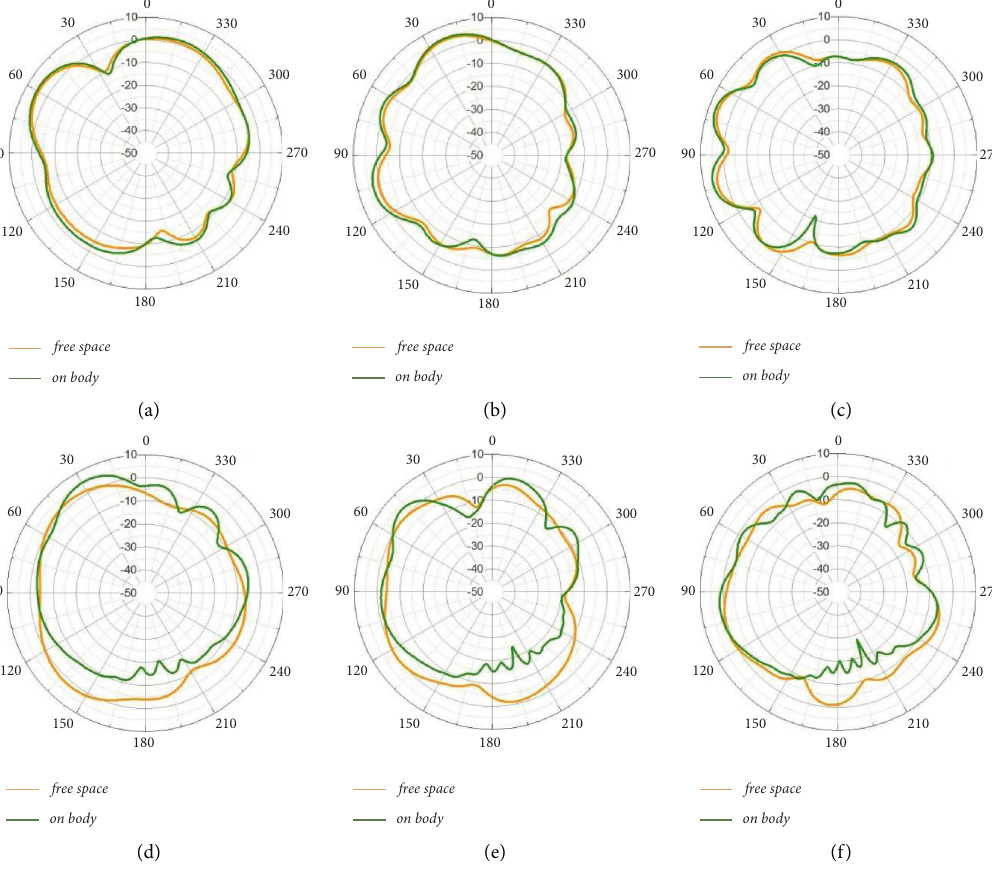
Figure 9: Free space versus on-body radiation pattern comparison: (a) XY-plane at 60GHz, (b) XY-plane at 80GHz, (c) XY-plane at 100GHz, (d) YZ-plane at 60GHz, (e) YZ-plane at 80GHz, and (f) YZ-plane at 100